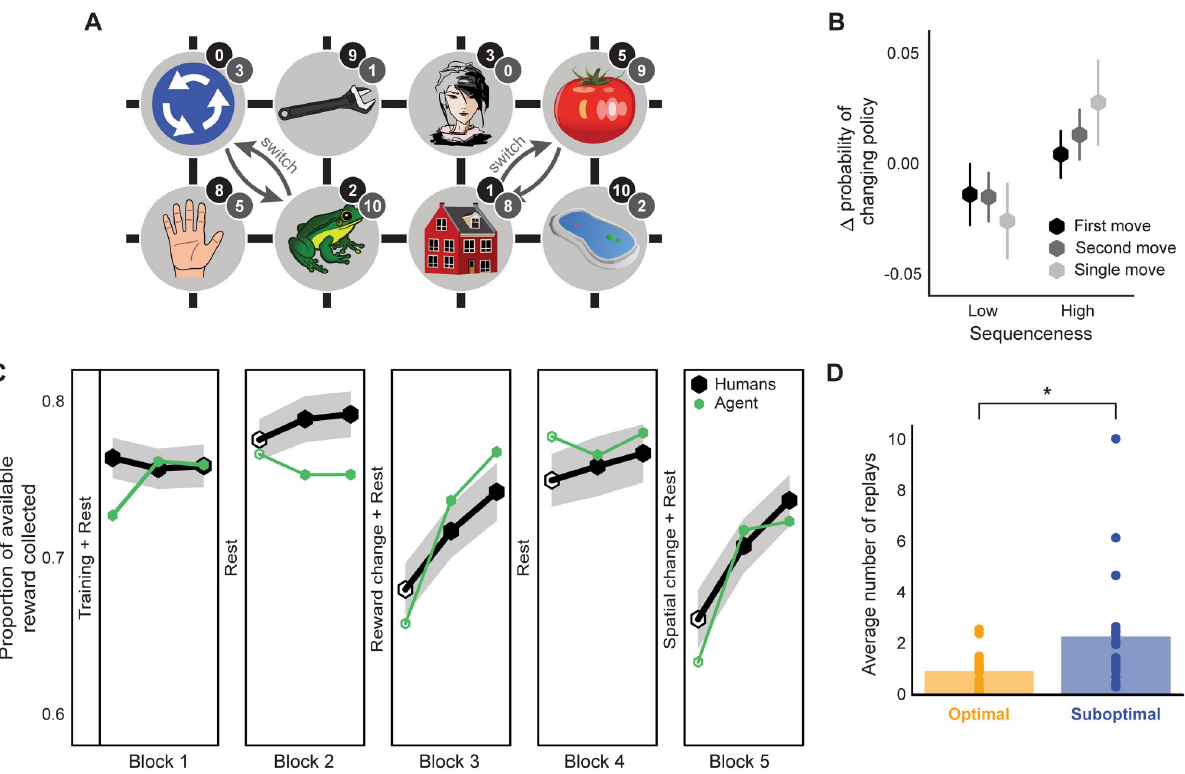
Fig 1. Task structure and replay modelling. (A) Structure of the state-space. Numbers in black and grey circles denote the number of reward points associated with that state respectively pre- and post- the reward association change between blocks 2 and 3. Grey arrows show the spatial re- arrangement that took place between blocks 4 and 5. Note that the stimuli images shown here differ from those which the subjects actually saw. (B) Change in the probability of choosing a different move when in the same state as a function of sequenceness of the just-experienced transitions measured from the MEG data in subjects with non-negligible sequenceness ( n = 25). High sequenceness was defined as above median and low sequenceness as below median. Analysis of correlation between the decoded sequenceness and probability of policy change indicated a significant dependency (Spearman correlation, M = 0.04, SEM = 0.02, p = 0.04, Bootstrap test). Vertical lines show standard error of the mean (SEM). (C) Performance of the human subjects and the agent with parameters fit to the individual subjects. Unfilled hexagons show epochs which contained trials without feedback. Shaded area shows SEM. (D) Pessimism bias in the replay choices of human subjects for which our model predicted sufficient replay ( n = 20) as reflected in the average number of replays of recent sub-optimal and optimal transitions at the end of each trial (sub-optimal vs optimal, Wilcoxon rank-sum test, W = 2.49, p = 0.013). �� p <